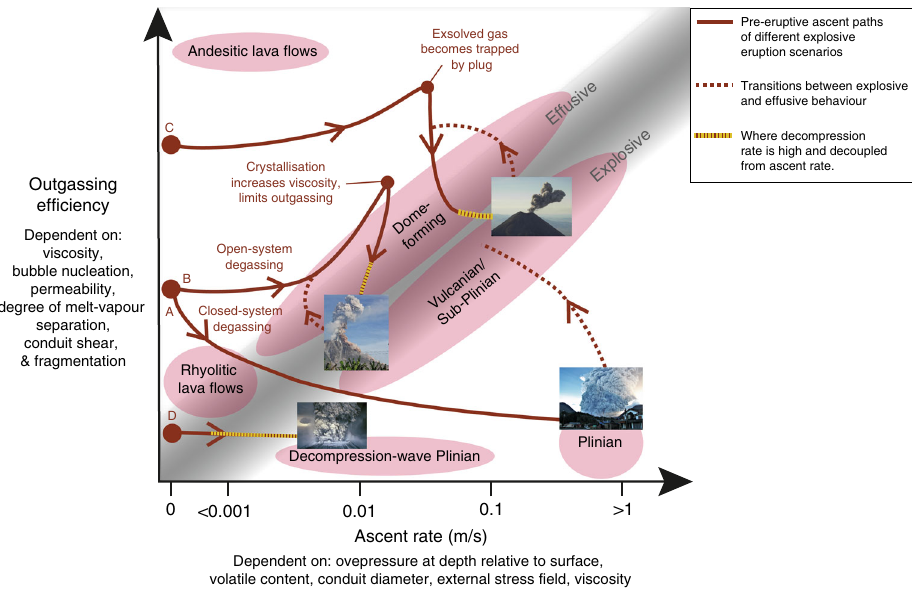
Fig. 7 Schematic plot, where an diffuse threshold distinguishes effusive from explosive eruptions. Points a – d represent different eruptive scenarios: a = Ascent controlled (bottom-up), b = Viscosity controlled, c = Exsolved gas accumulation and plug controlled, and d = Decompression-wave controlled. The red lines are pre-eruptive ascent paths and do not represent transitions between effusive and explosive behaviour, where the eruption photo represents a magma reaching the surface. The starting position on the outgassing ef fi ciency axis depends on the magma rheology (composition and crystallinity) and permeability. Note that this fi gure is schematic, the ascent rates are based on Fig. 3 (syn-eruptive averages). However, currently no data exists on how ascent and decompression rates evolve during transit from storage to surface. In addition, due to the complex and variable nature of magmatic outgassing, and how this changes with crystallization, viscosity and bubble nucleation during ascent, data on this parameter are currently lacking. Nevertheless, quantifying these parameters during the magma ’ s transit from storage to surface in the future, may prove crucial for understanding the controls on eruptive style and where in the crust these controls are most important. Eruption photos in this fi gure are sourced from Chaiten in 2008 (Daniel Basualto), Soufrière Hills, 1997, Volcan de Colima (Mike Cassidy) and Mt St. Helens in